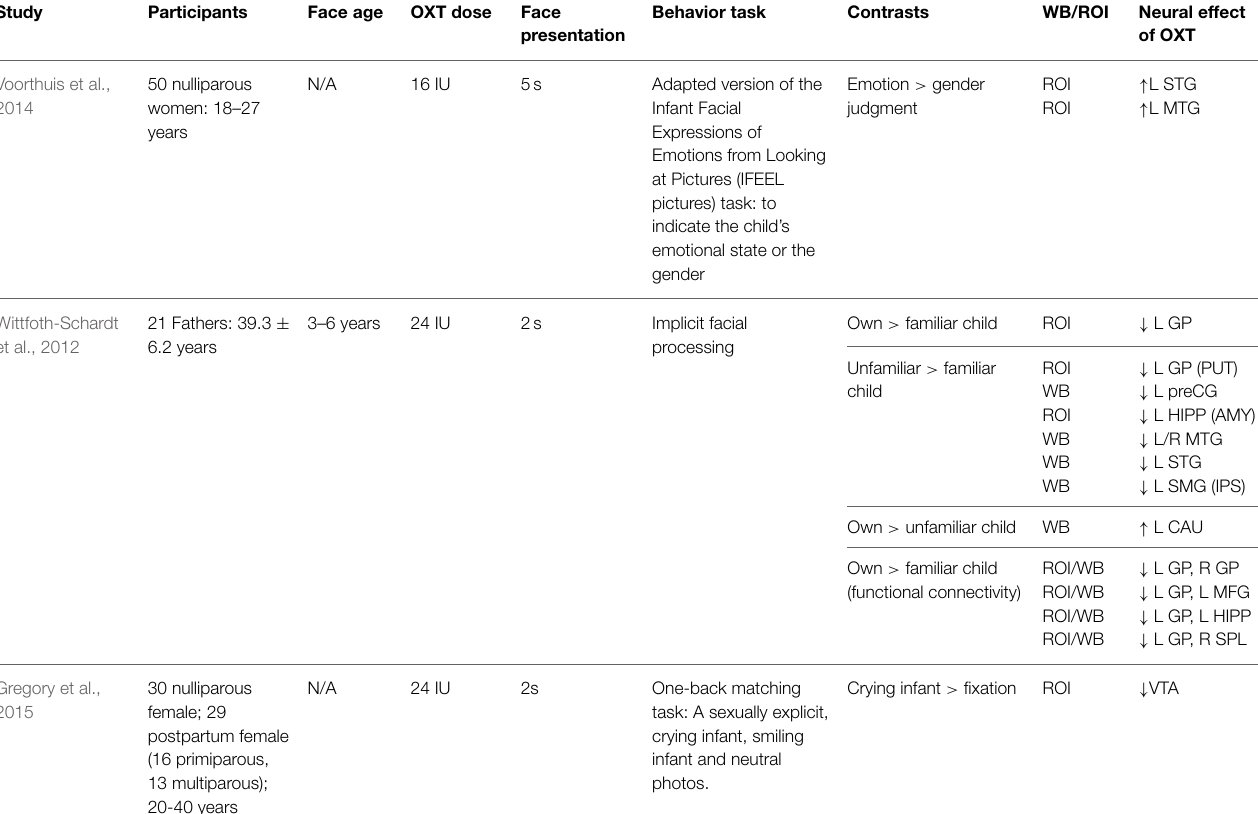
TABLE 3 | The effect of oxytocin administration on brain response to infant and child faces.